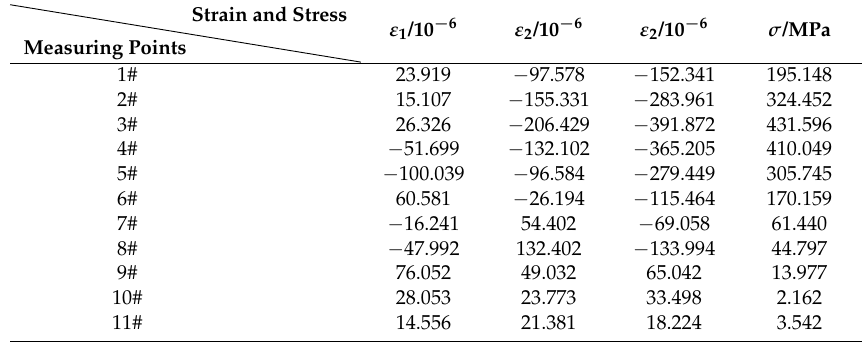
Table 3. Strain value ε 1 , ε 2 , ε 3 and stress value σ of measuring points inside the specimen with Fe-Mn-Si SMAs welding